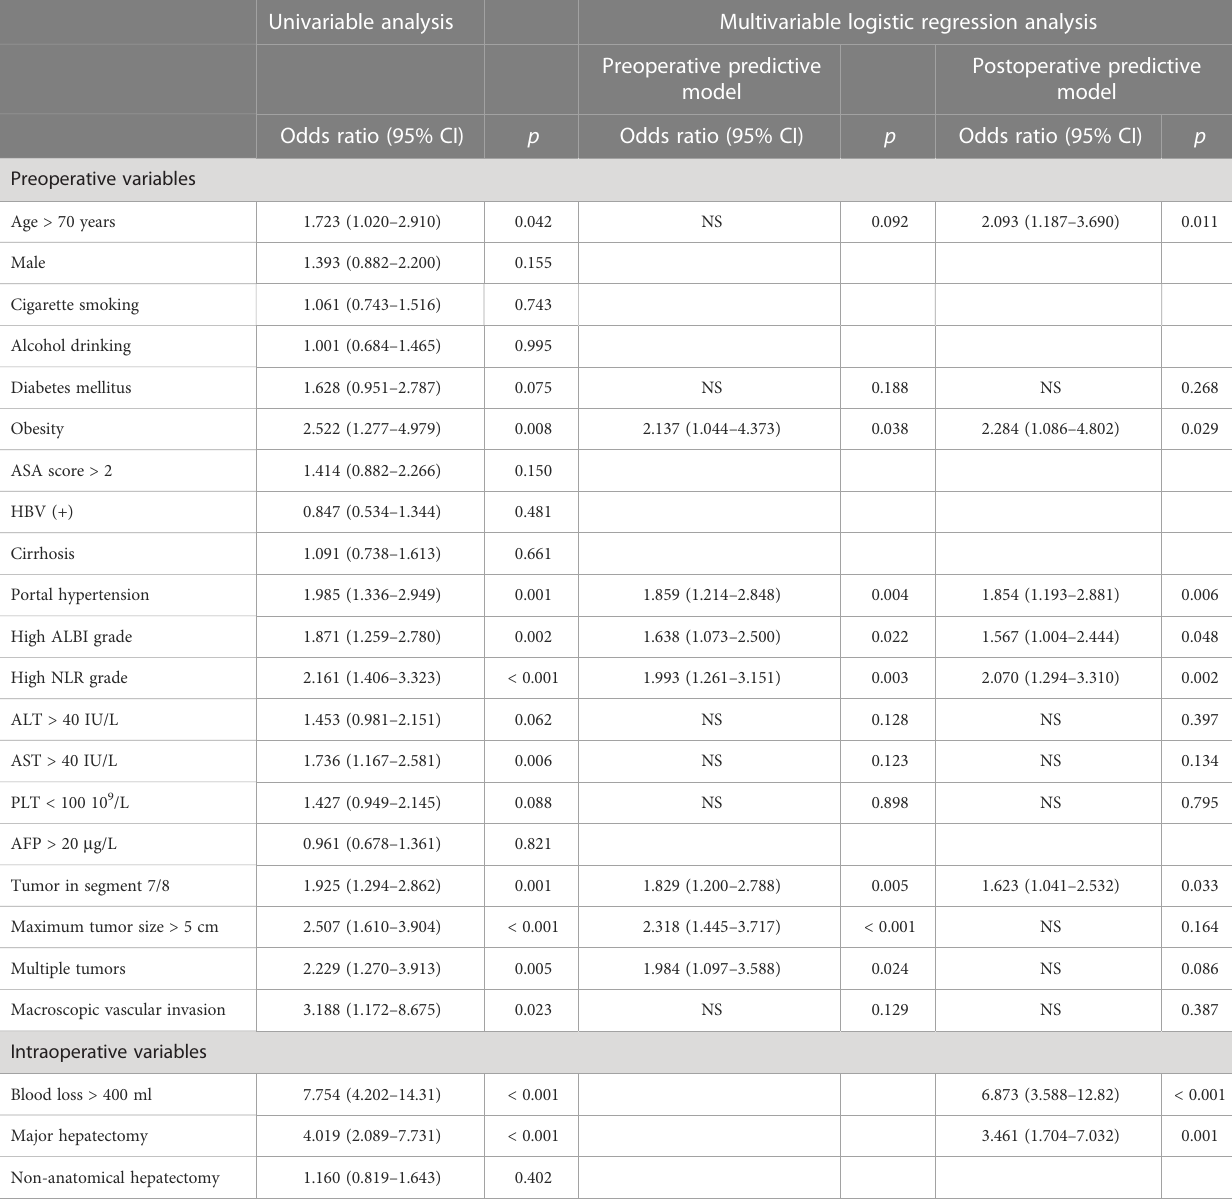
TABLE 2 Univariable and multivariable logistic regression analyses of risk factors associated with not achieving a textbook outcome following hepatectomy for HCC. Univariable analysis Multivariable logistic regression